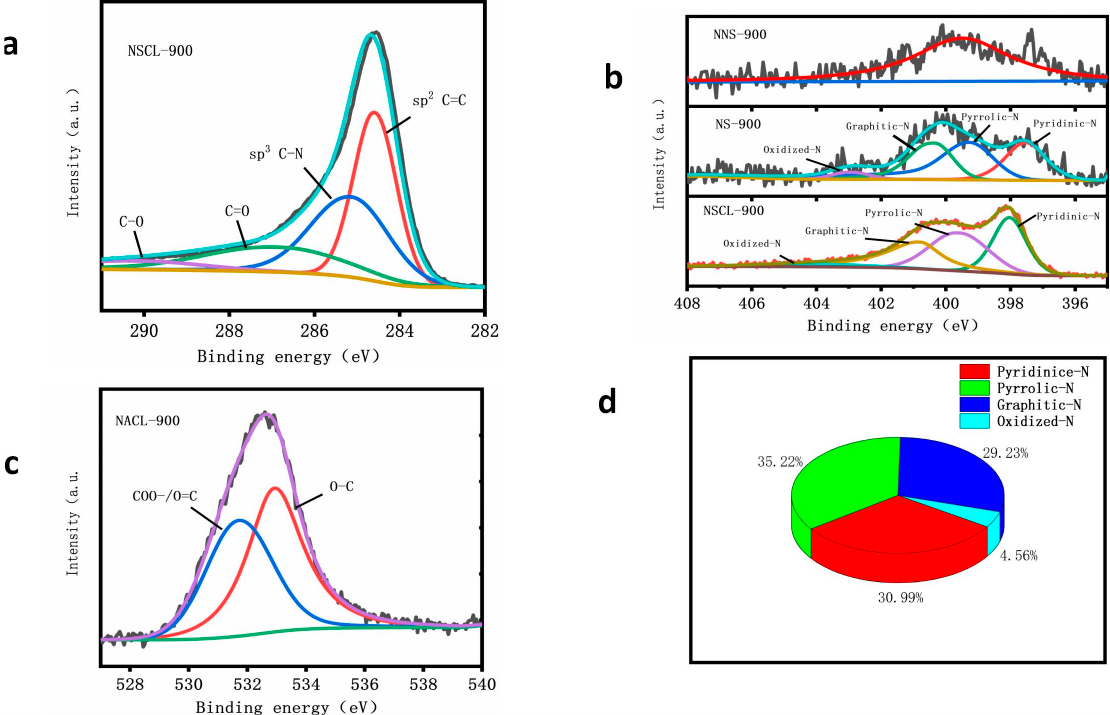
Figure 4. High-resolution N1s spectrograms of NSCL-900, NS-900, and NNS-900 ( b ), and high-resolution C1s ( a ) and O1s ( c ) spectrograms of NSCL-900. Figure ( d ) shows the content of nitrogen functional groups in NSCL-900.